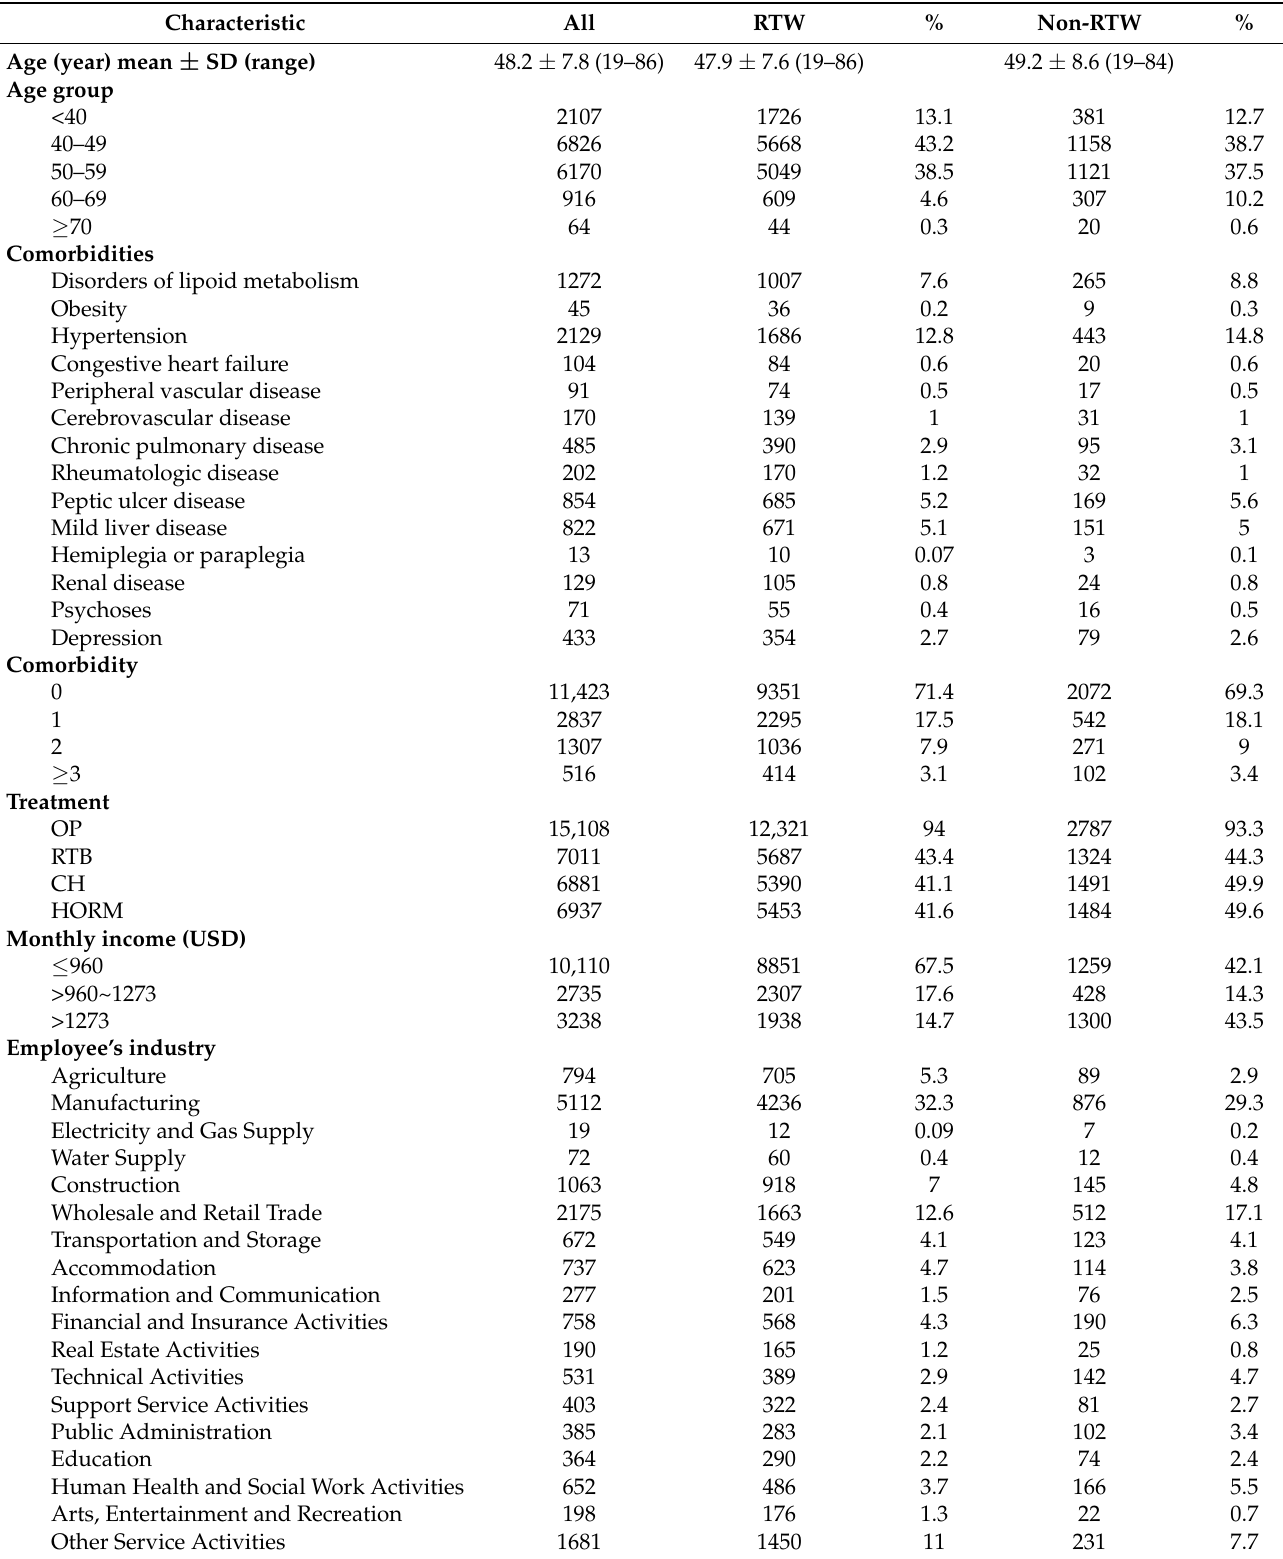
Table 1. Characteristics of the study